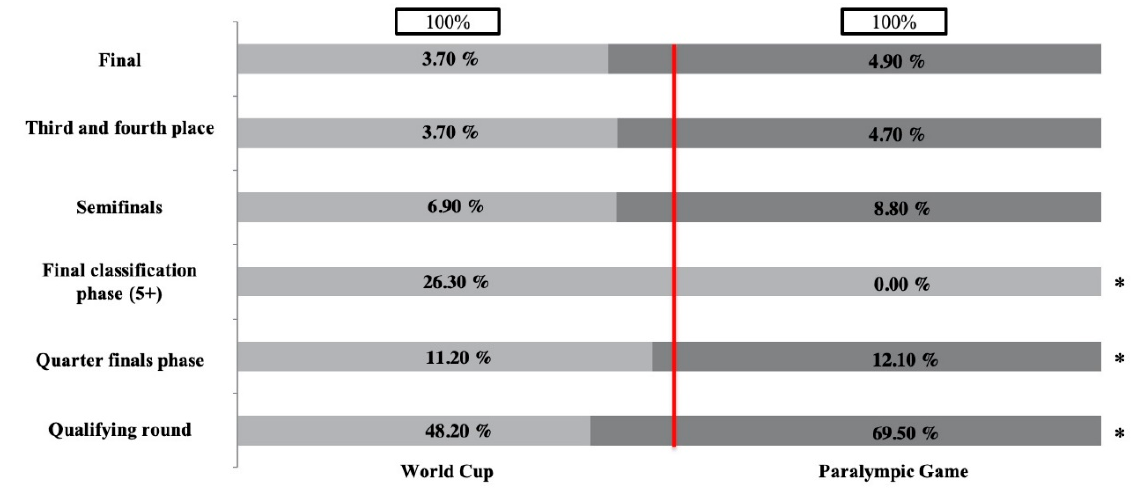
Figure 1. Distribution of goal throws according to the championship phases. * ASR > |1.96|.